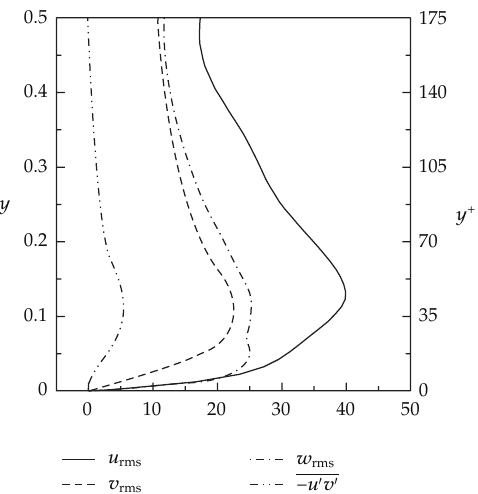
Figure 12: Distribution of scaled (cid:2) × 100 (cid:3) resolved turbulent quantities at center plane (cid:2) z (cid:8) 0 . 5 (cid:3) plotted at x/e (cid:8) 1 . 5 just downstream of reattachment